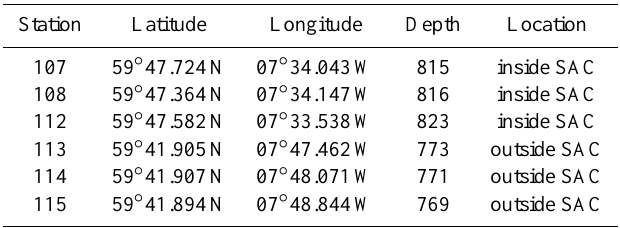
Table 1. List of sampling stations inside and outside the Darwin Mound SAC.